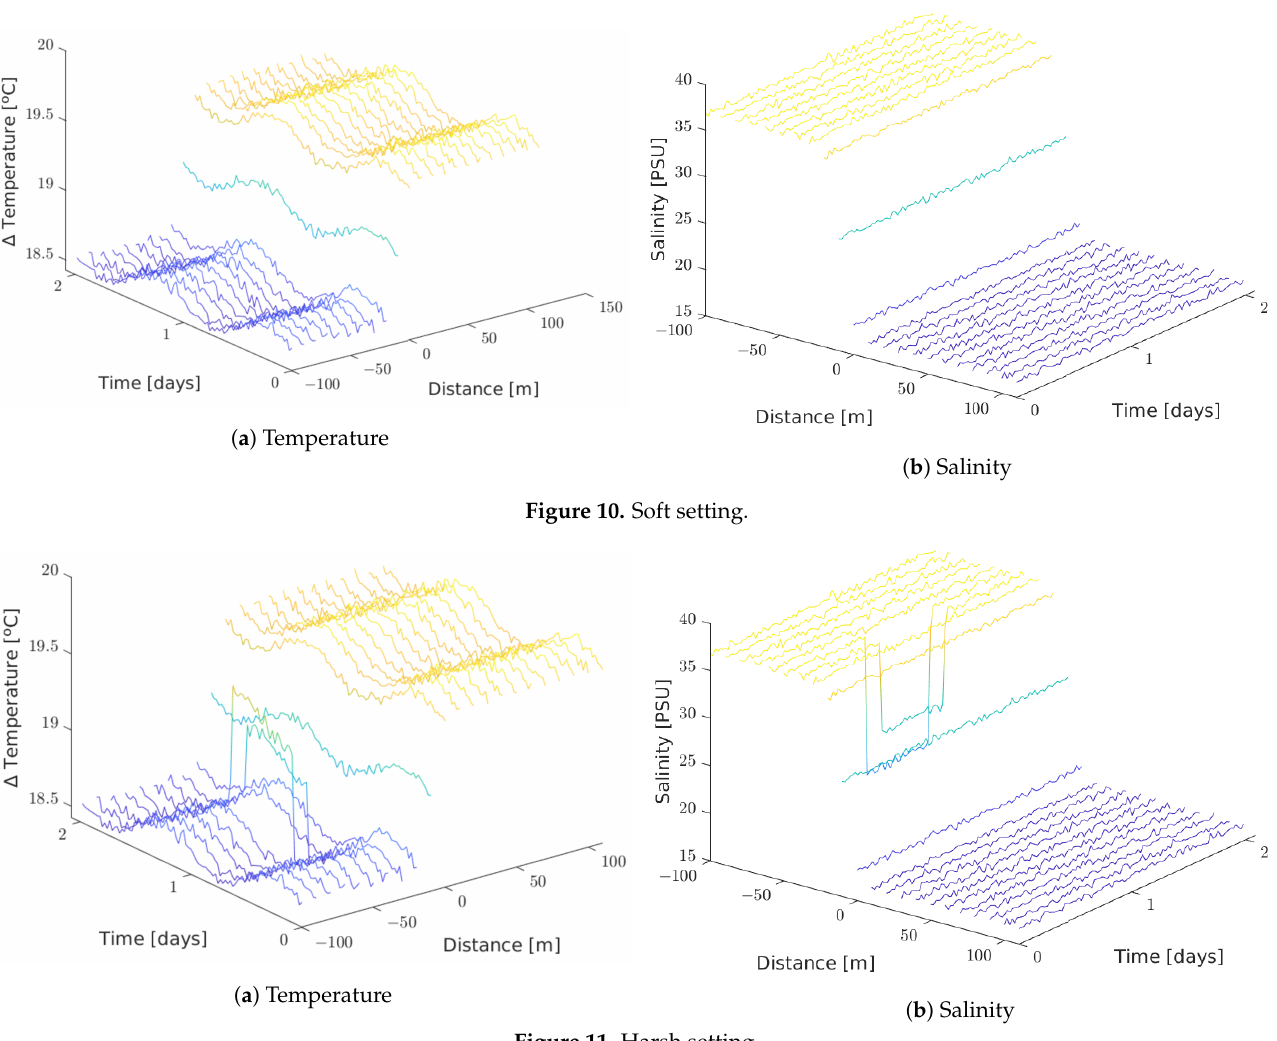
Figure 11. Harsh